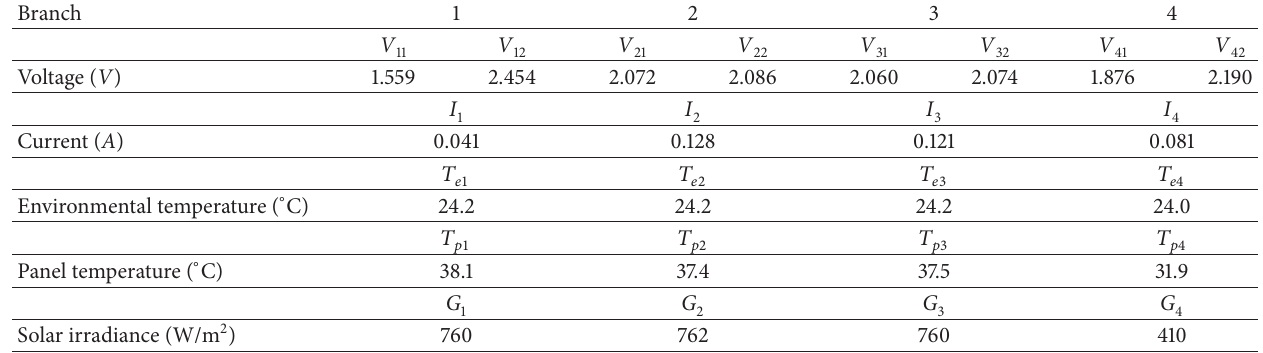
Table 1: Data collected by experimental system.